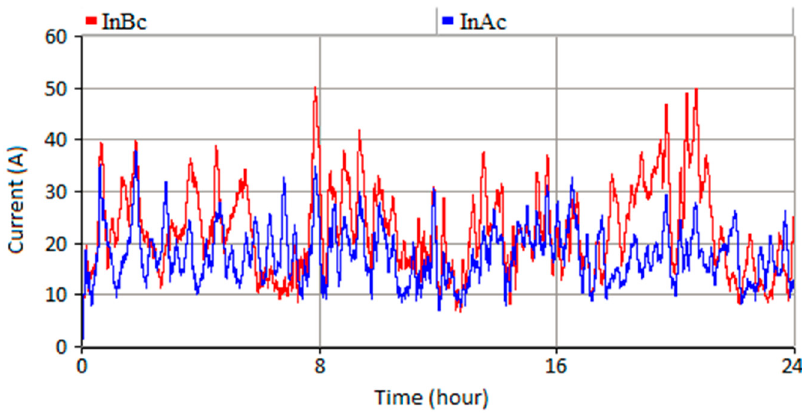
Figure 24. NCC under communication delay for case Bc against case Ac.